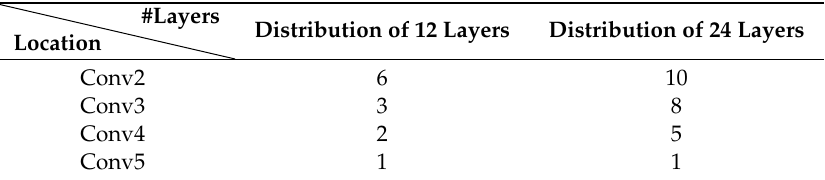
Table 4. Configuration of the depth test.